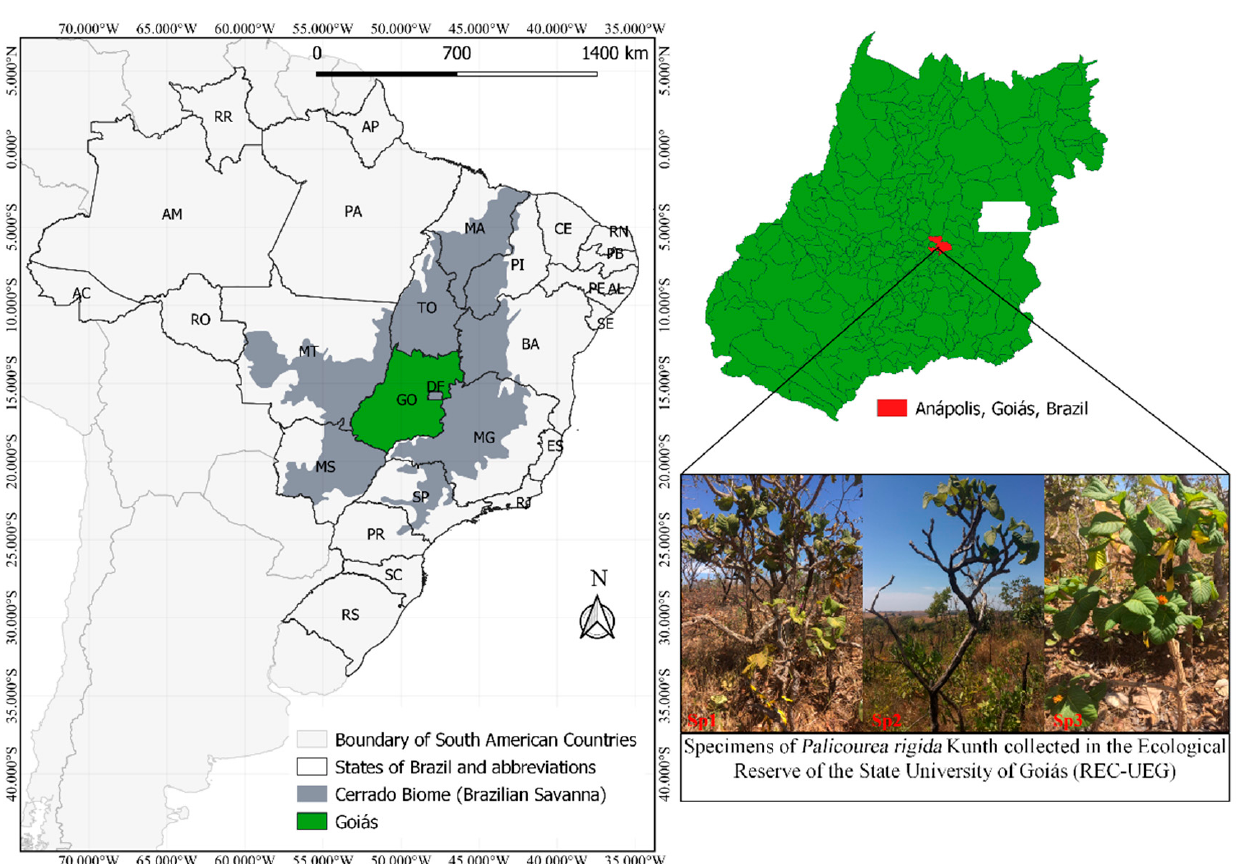
Figure 1. Geographic location of the UEG Ecological Reserve (REC-UEG), Anápolis, Goiás, Brazil and specimens of Palicourea rigida sampled.